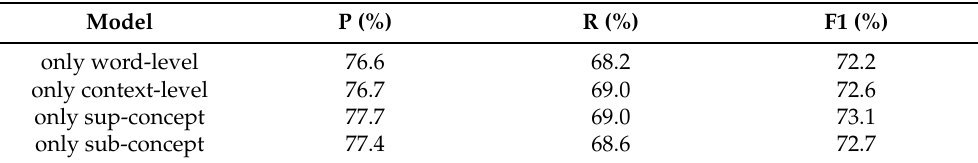
Table 6. Performance of the effect of word-level representation, context-level representation, superor- dinate concepts and subordinate concepts on the